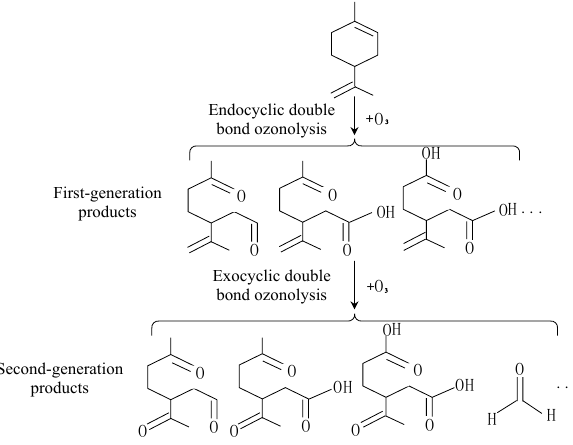
Figure 2. The reaction scheme of endocyclic and exocyclic double bonds in limonene